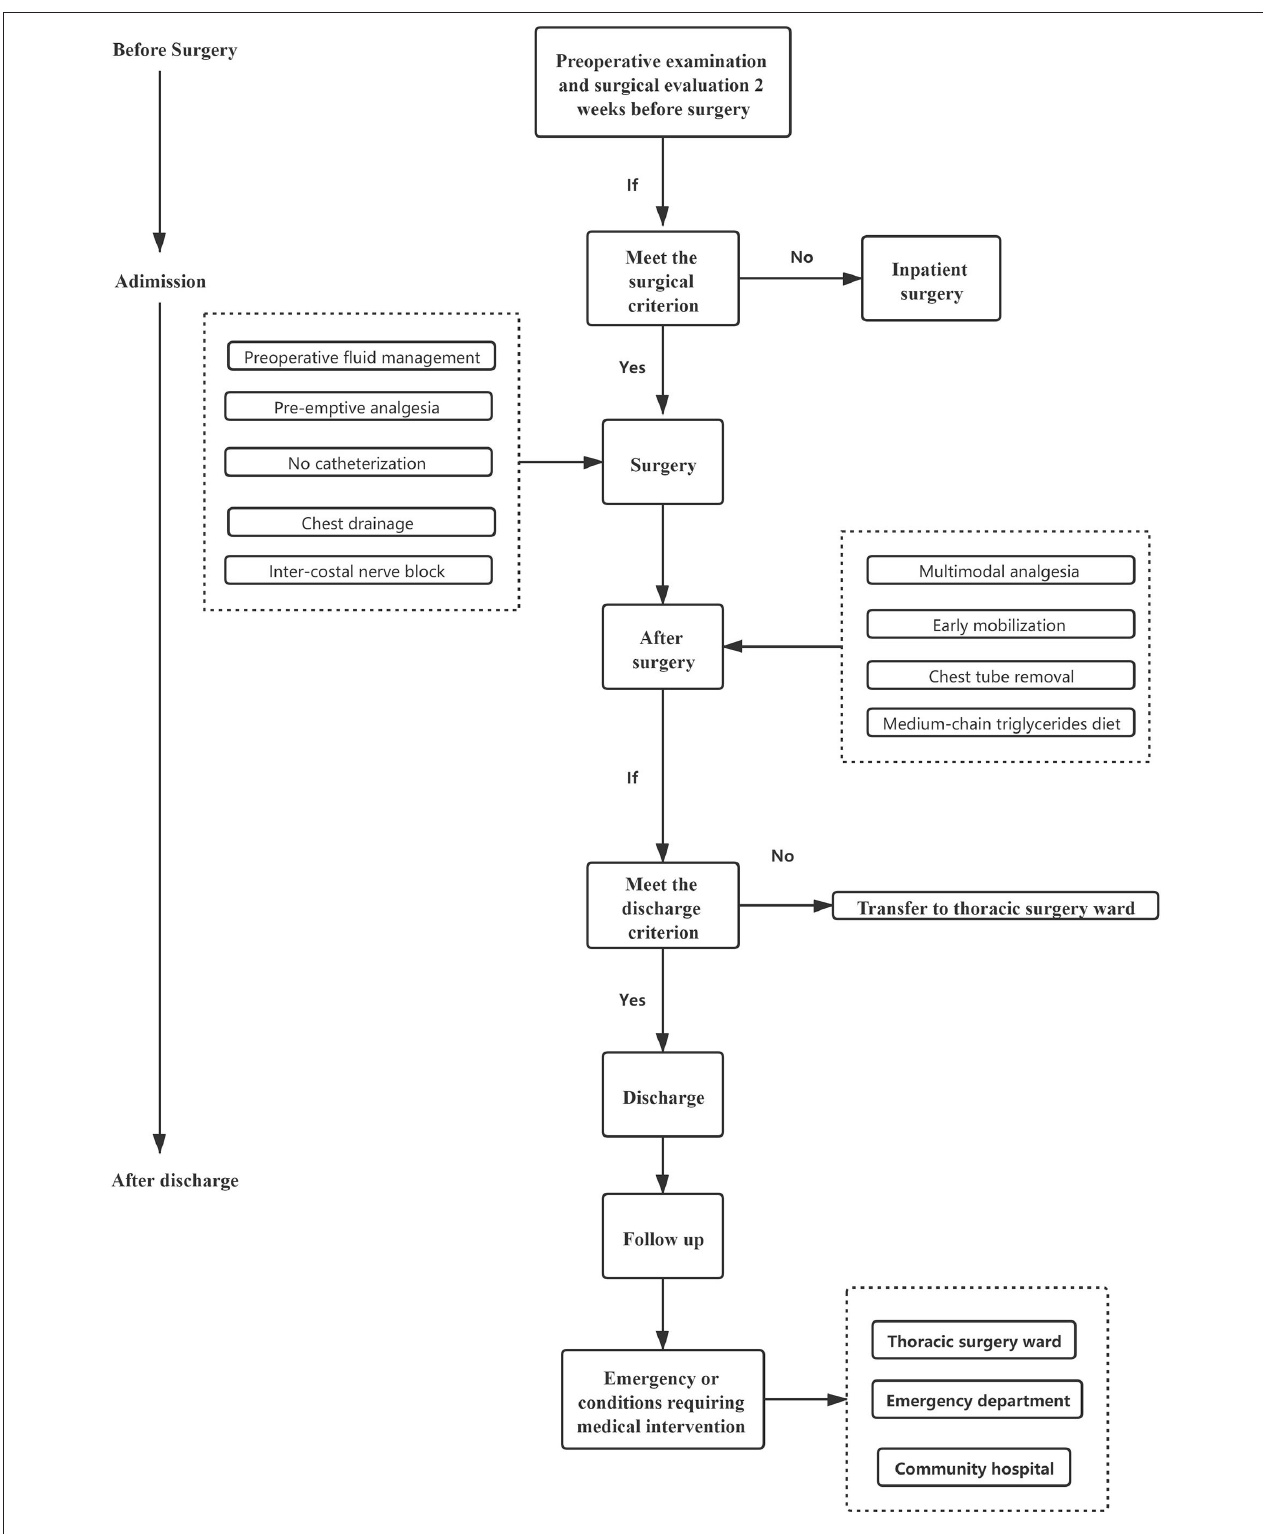
FIGURE 6 | Clinical pathway management of video-assisted thoracoscopic day surgery (VATDS).